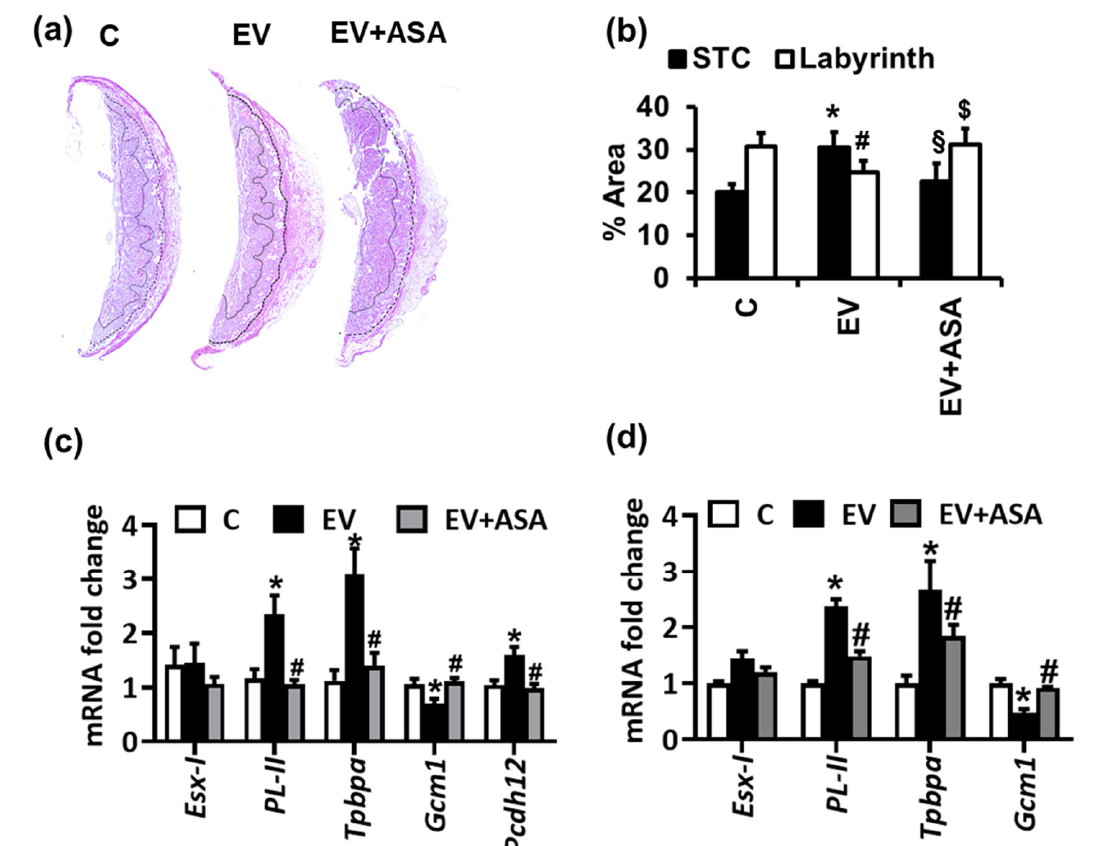
Figure 2. Platelet inhibition using aspirin prevents EV-induced impaired trophoblast differentiation. ( a , b ) Hematoxylin and eosin (H&E) stained placentae. ( a ), representative images; ( b ), bar graph summarizing results) showing restoration of labyrinth zone (LZ) and junctional zone (LZ) relative area in placenta from EV-injected mothers upon aspirin treatment. * p < 0.05 (STC, relative to C), # p < 0.05 (labyrinth, relative to C), § p < 0.05 (STC, relative to EV), $ p < 0.05 (labyrinth, relative to EV); ANOVA. ( c , d ) qPCR analysis for trophoblast differentiation markers in mouse placenta ( c ) or mouse trophoblast stem cells ( d ) showing that inhibition of platelet activation by aspirin prevents the EV-induced increase in spongiotrophoblast marker ( Tpbpa ), giant trophoblast marker ( PL-II ) and glycogen-rich cell marker ( Pcdh12 ). In parallel, aspirin prevents the EV-induced decrease in syncytiotrophoblast marker Gcm-1 in mice ( c ) or trophoblast cells ( d ). * p < 0.05 (relative to C), # p < 0.05 (relative to EV); ANOVA ( c , d ). n = 6 placentae from 3 different litters each group ( a – c ) or 3 independent repeat experiments ( d ).